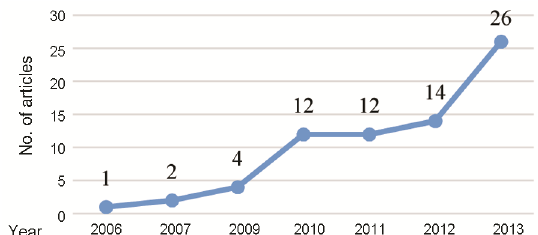
Fig. 7. Articles on information analysis and reporting